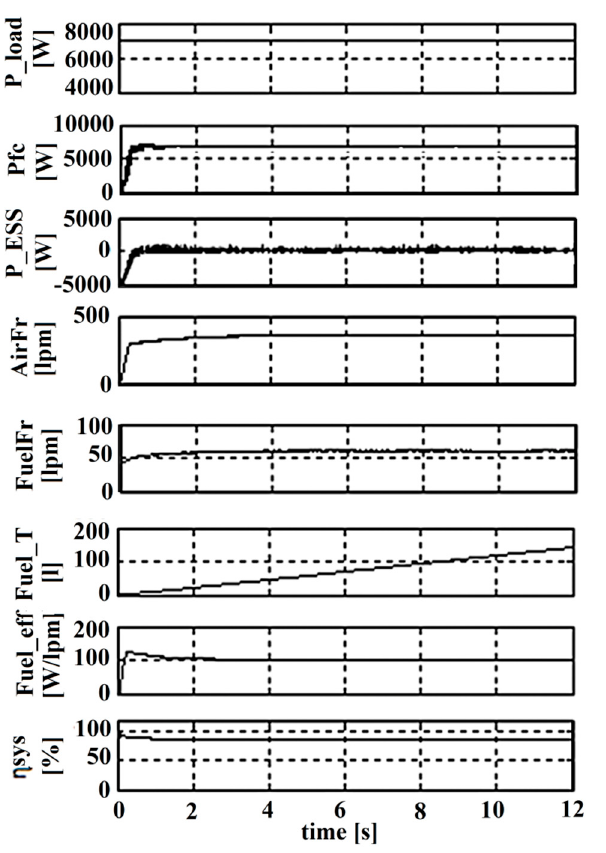
Figure 7. Fuel-LFW-based strategy.